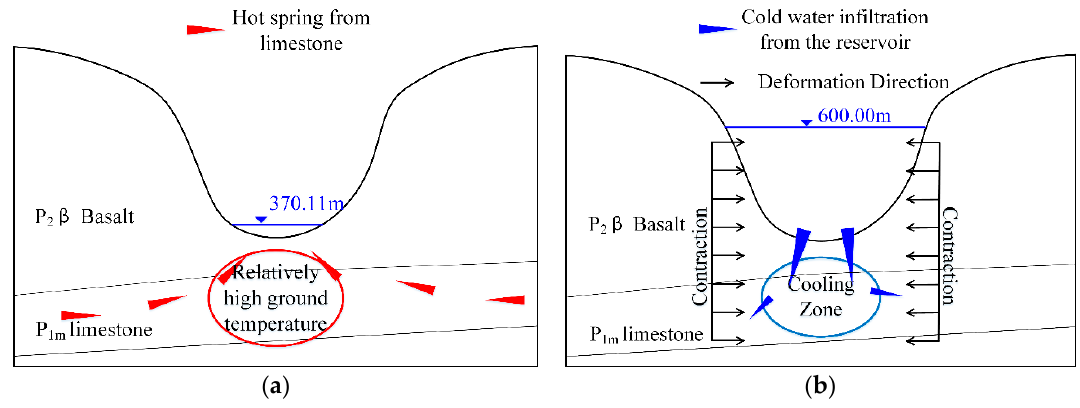
Figure 10. Valley deformation mechanism is driven by thermal field variation: ( a ) hydrogeological condition before impoundment; ( b ) deformation pattern caused by cold water infiltration after impoundment.